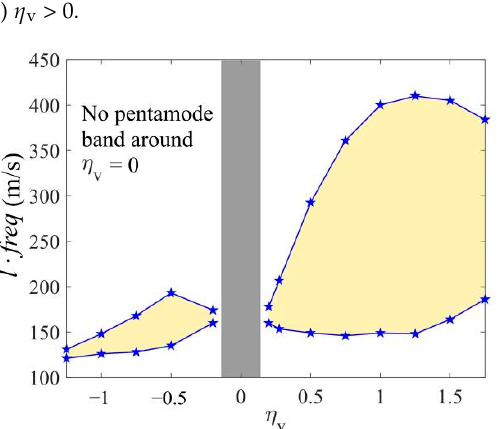
Figure 2. The variation in the primitive cell by moving P 1 and P 2 vertically with ( a ) η v < 0 ( b ) η v = 0 ( c ) η v > 0.